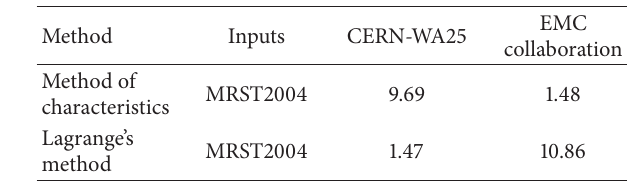
Table 1: 𝜒 2 /d.o.f. for (19) and (45).